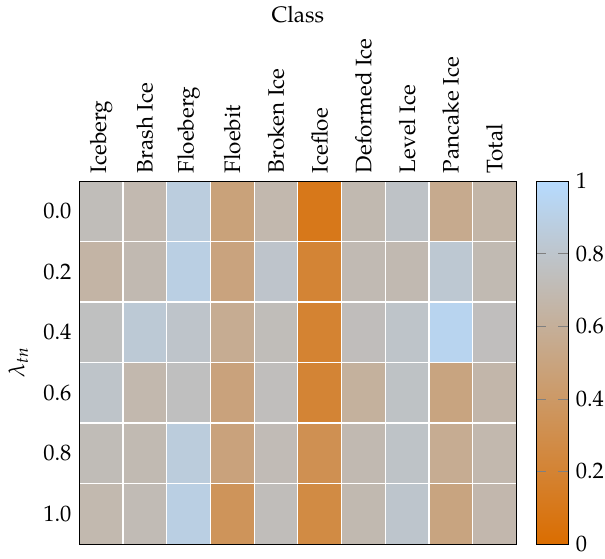
Figure 6. Heatmap of F 1 score for different values of λ tn and ice object classes. The score for each value of λ tn is the average of two models trained with that value.